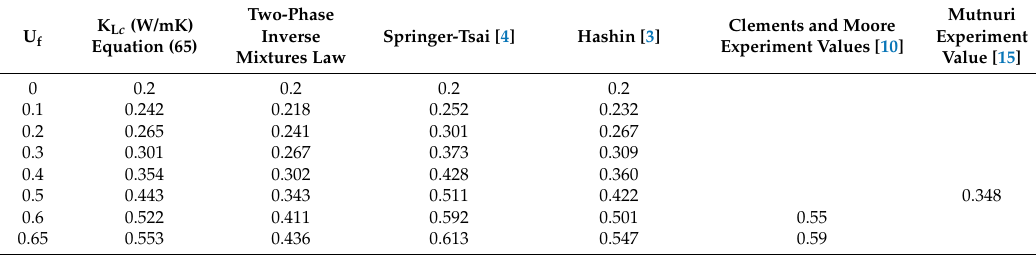
Figure 10. Theoretical values of longitudinal thermal conductivity versus filler content. Table 4. Transverse thermal conductivity of the composite for various filler contents.